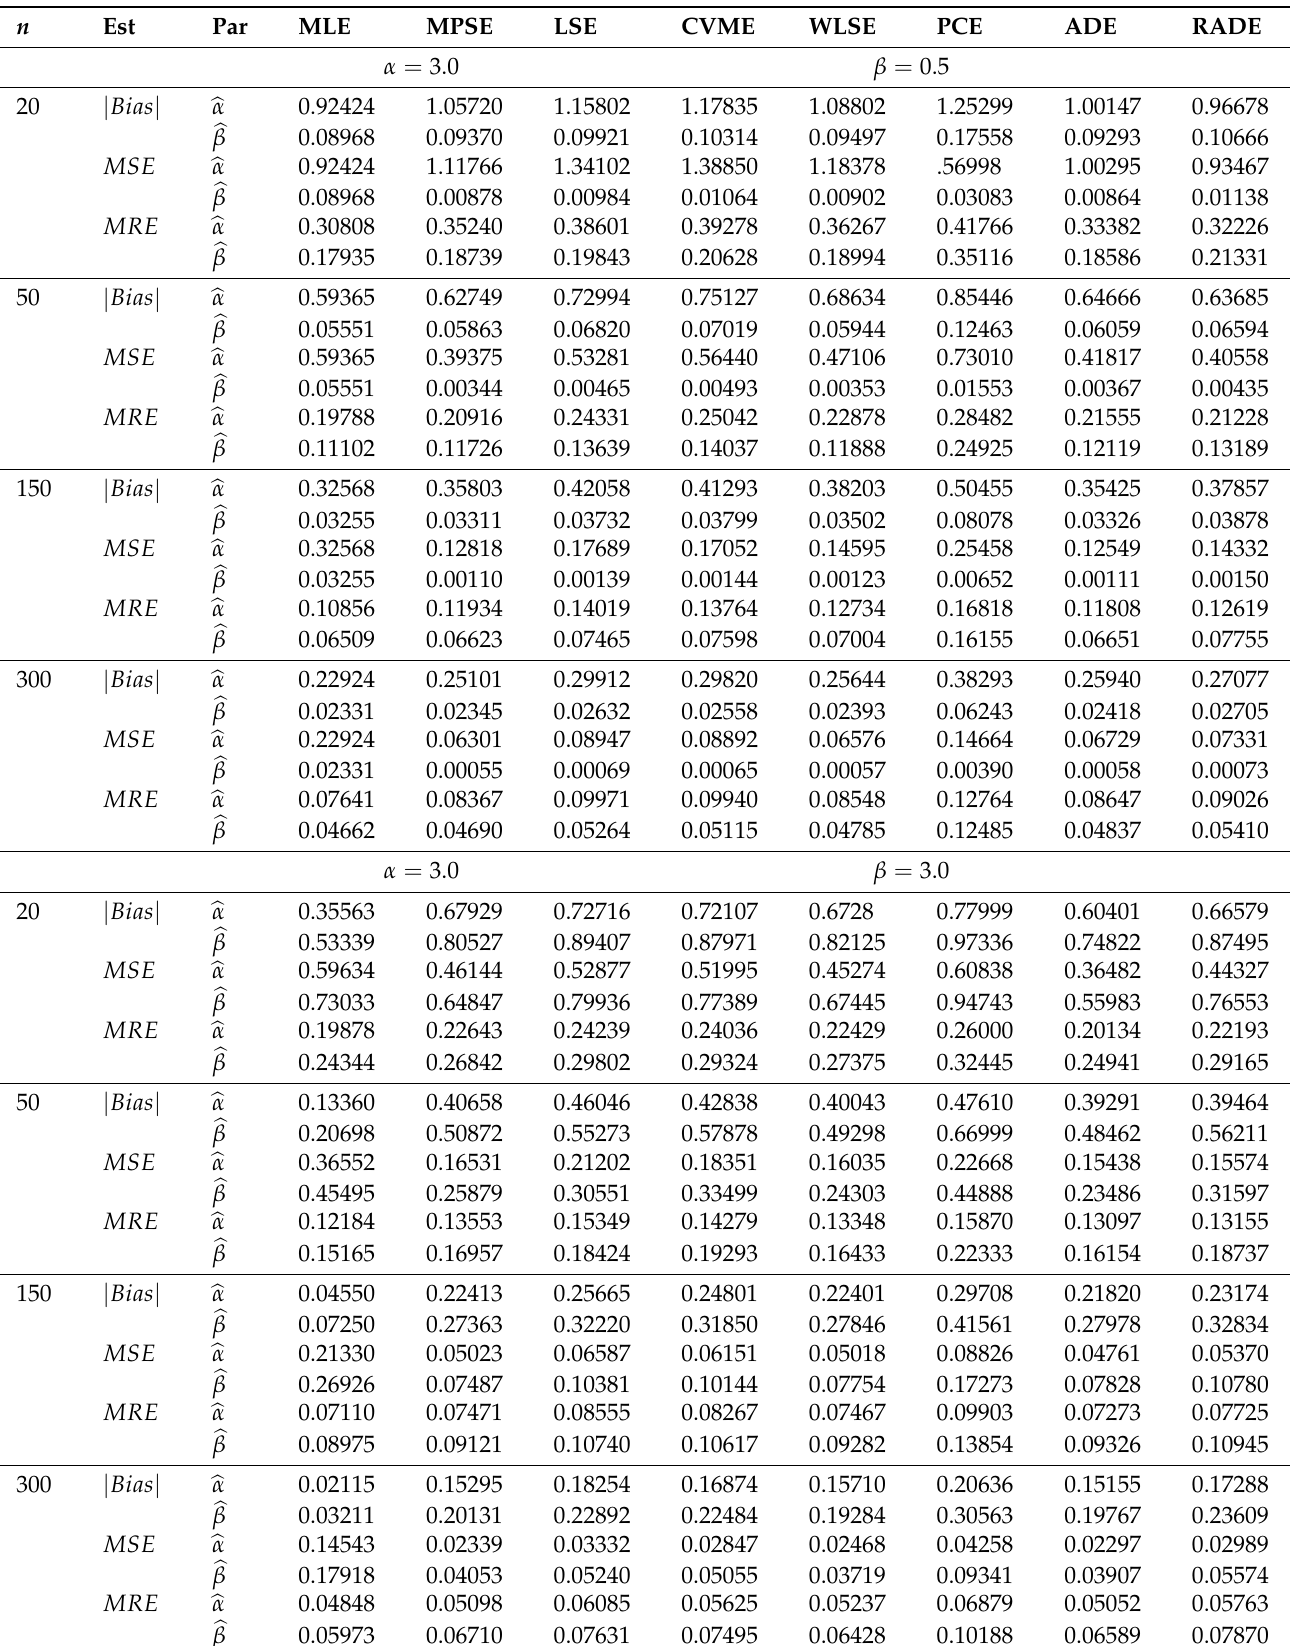
Table 6. Simulation results of the eight estimation methods for α = 3.0 and β =